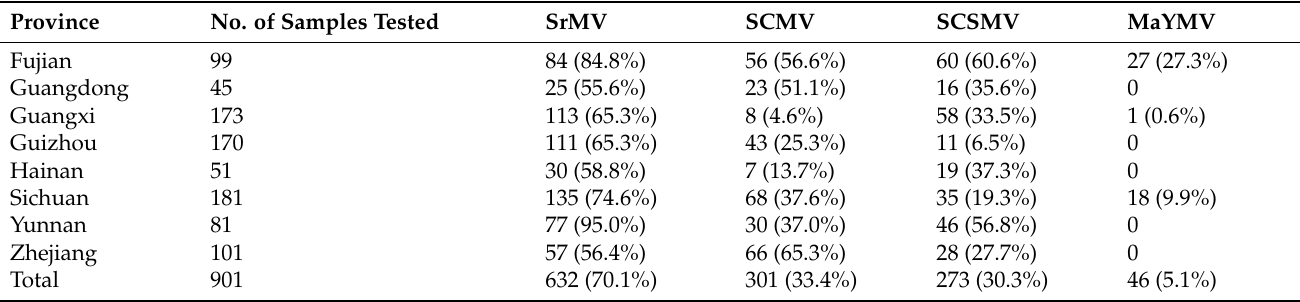
Table 1. Percentage (%) of SrMV, SCMV, SCSMV, and MaYMV infecting sugarcane in eight provinces in